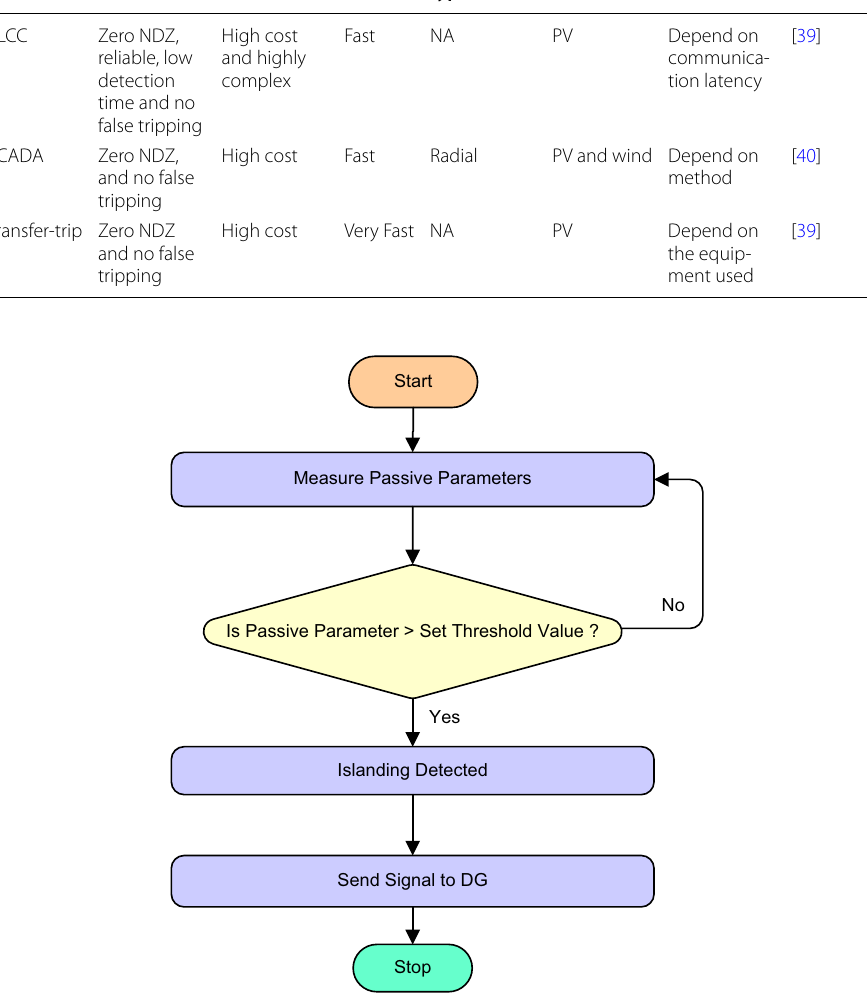
Fig. 4 Algorithm for passive islanding detection method